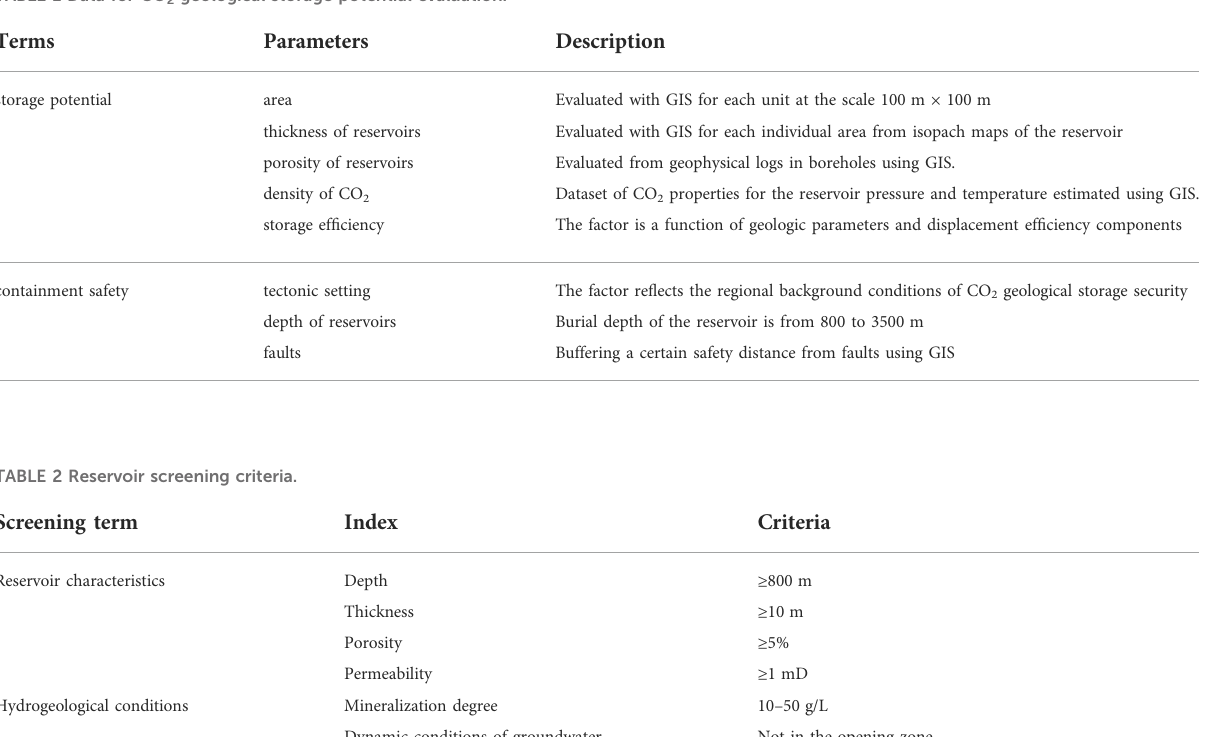
TABLE 1 Data for CO 2 geological storage potential evaluation.